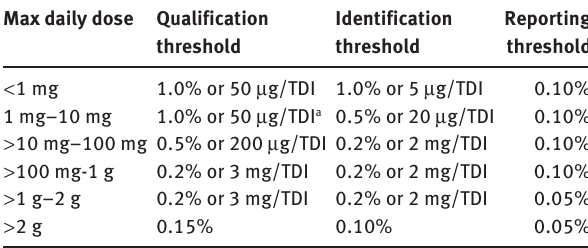
Table 2 Minimum degradation threshold for daily intake of drug